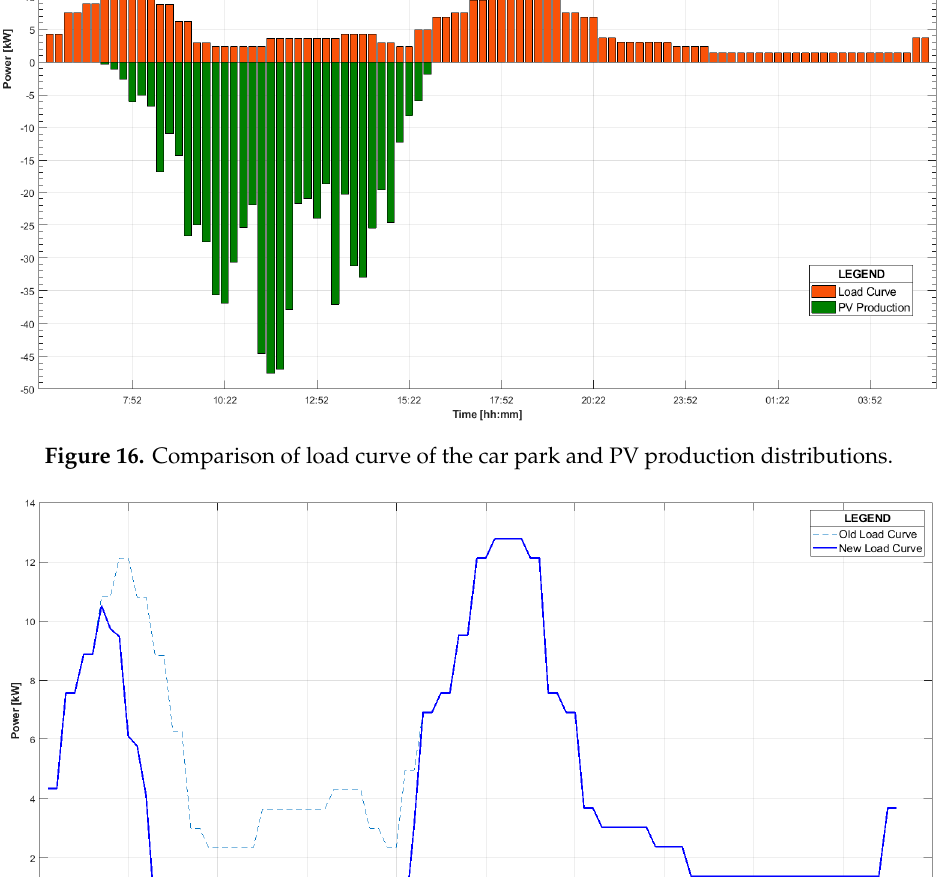
Figure 15. Flowchart of the “green” algorithm.